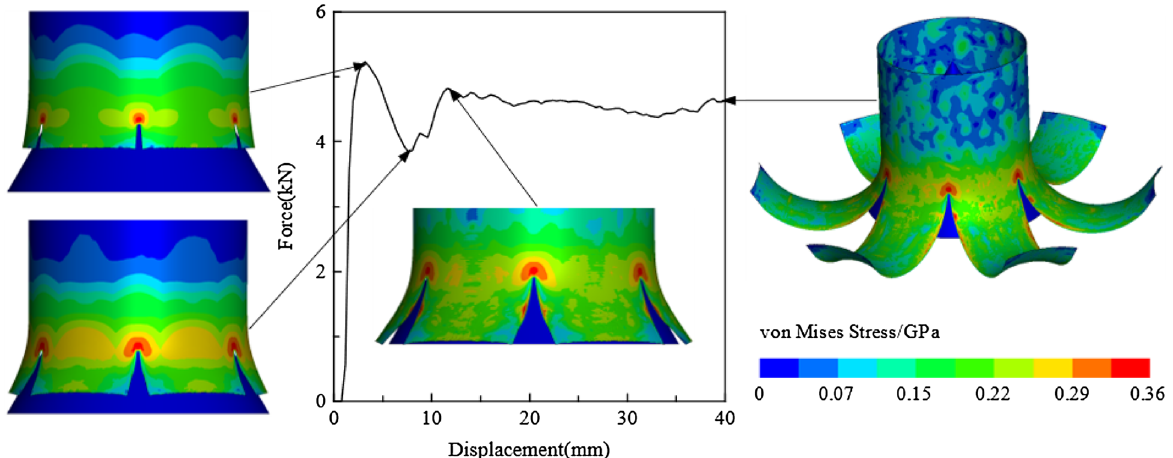
2.39, b r 1 and c CFS = =